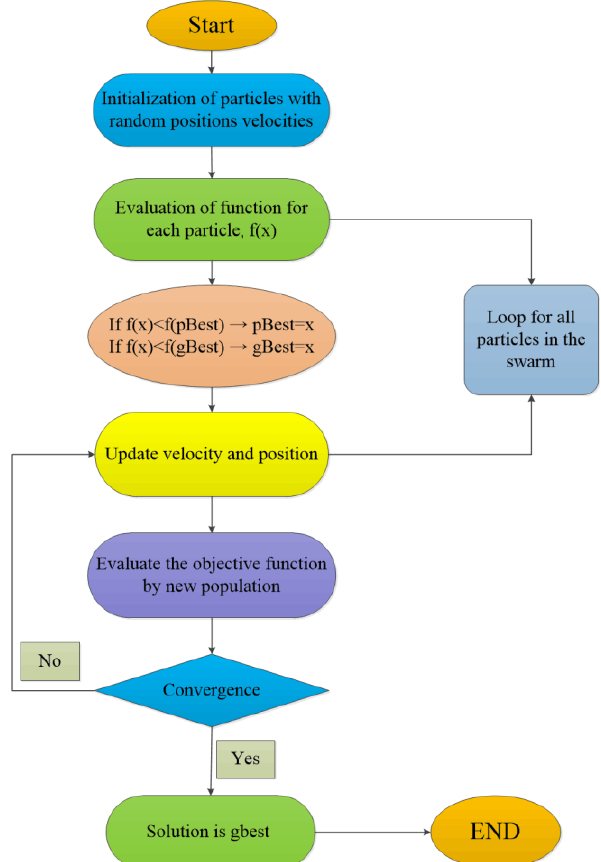
Figure 5. Flow chart of the PSO.